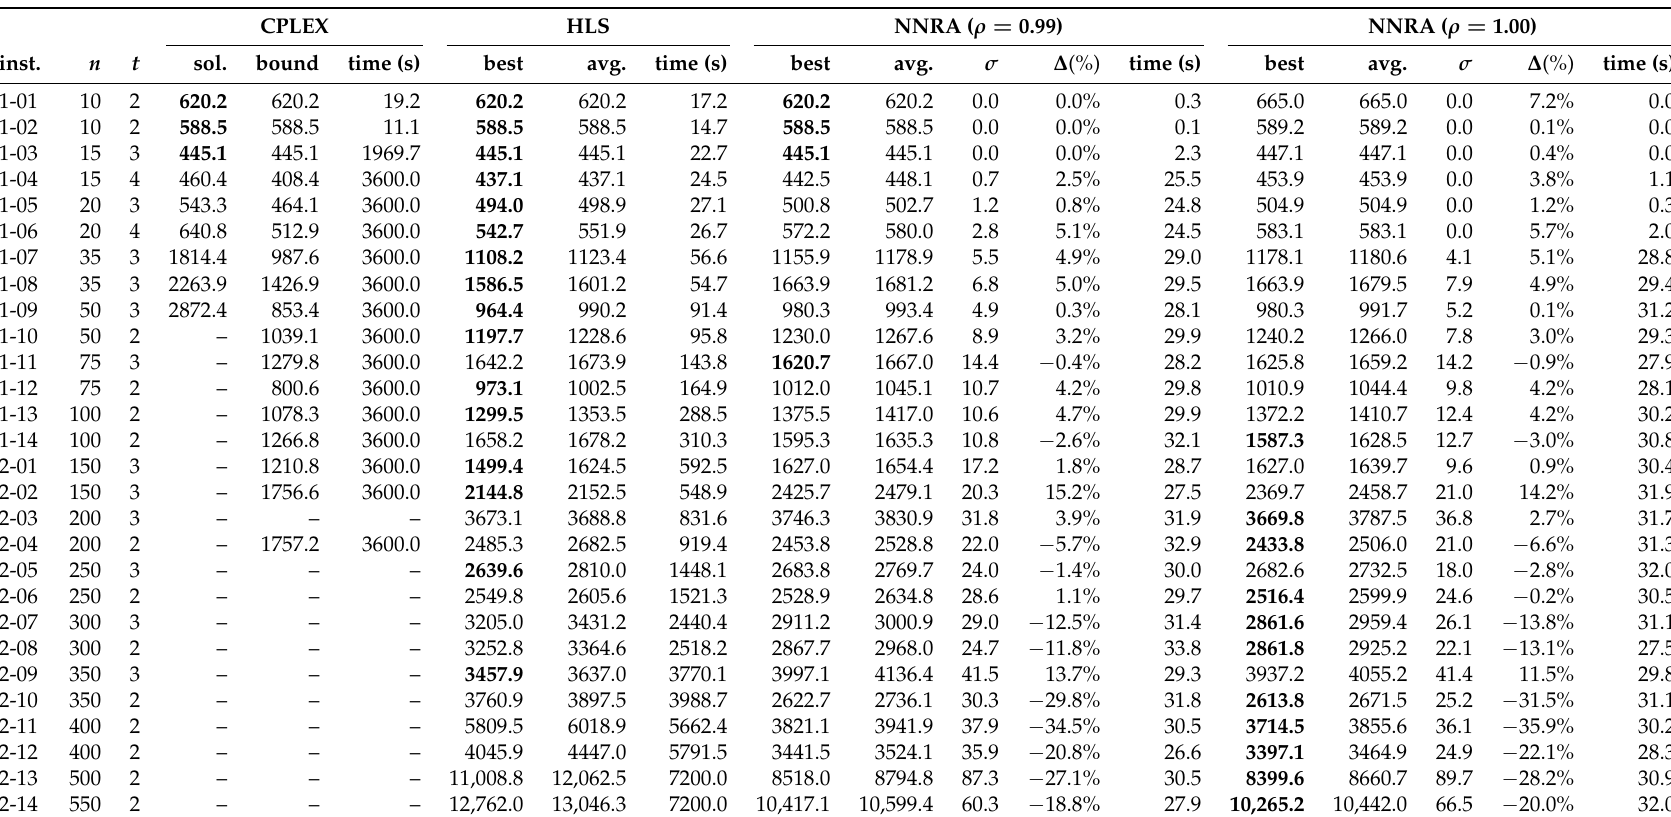
Table 6. Comparative results for benchmark instances of Avci and Topaloglu [13]. HLS—adaptive hybrid local search; NNRA—nearest-neighbor-based randomized